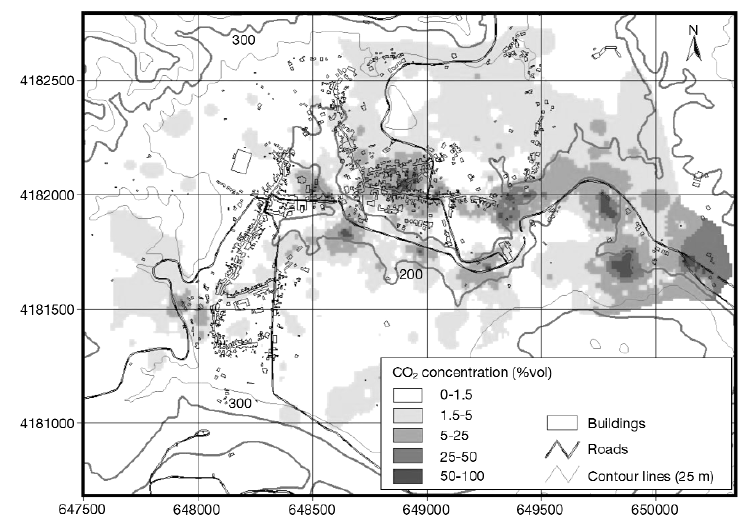
Fig. 7. CO 2 soil concentrations at Furnas village, S. Miguel Island (modified from Sousa,